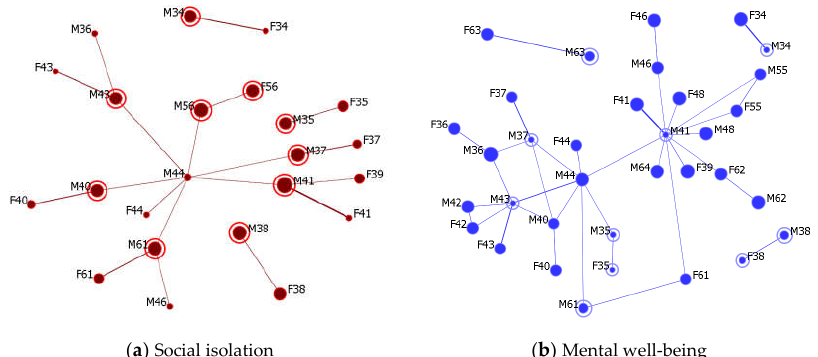
Figure 4. The potential dyads to identify supporters. Node size indicates the social isolation and mental well-being scores, while the links’ width is proportional to the support score. For graph clarity, the links are only shown if their weights (the support scores) are sufficiently large (above 1.0).